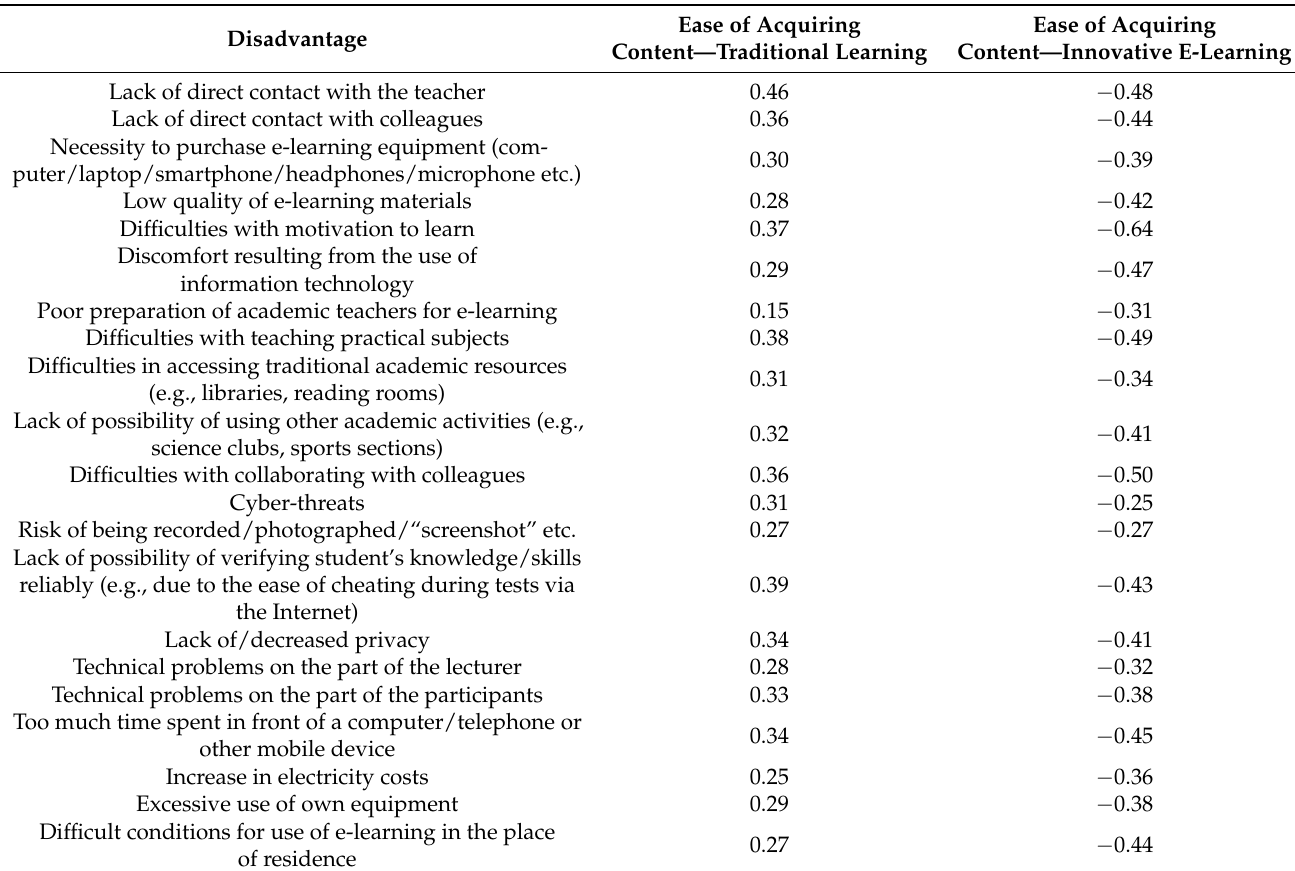
Table 5. Sperman’s rank correlations between the disadvantages of using innovative e-learning and the ease of acquiring content by students in traditional learning and